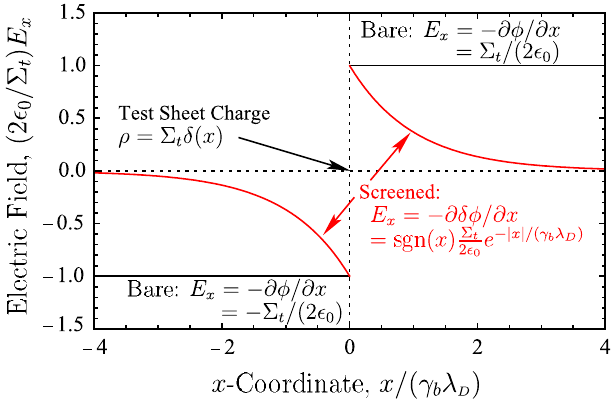
FIG. 5. Contrast of the bare (black) and screened (red) electric field of a test sheet charge inserted at x ¼ 0 in a thermal equilibrium sheet